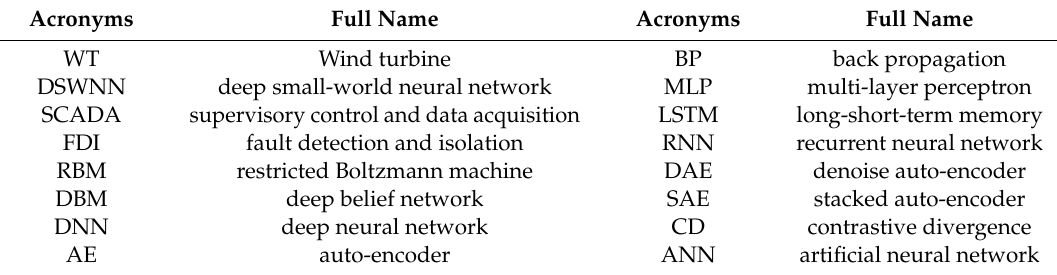
Table A1. Acronyms list.